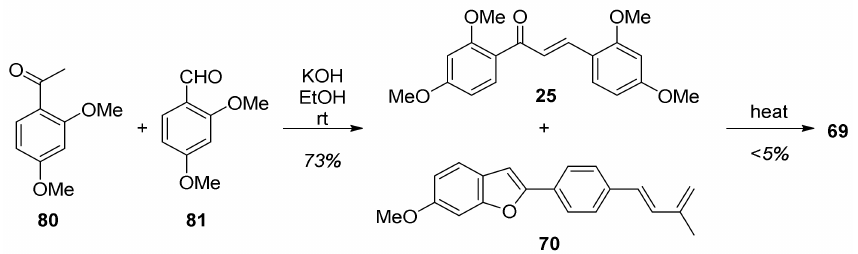
Figure 23. Synthesis of chalcone 25 and attempted Diels–Alder reaction between 70 and 25 .